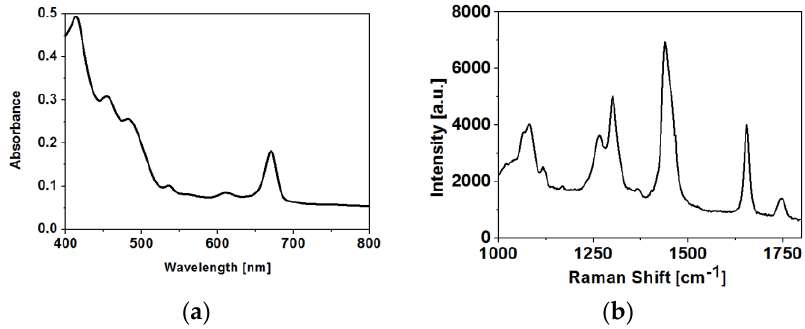
Figure 2. ( a ) Visible absorption spectrum and ( b ) Raman spectrum of olive oil.